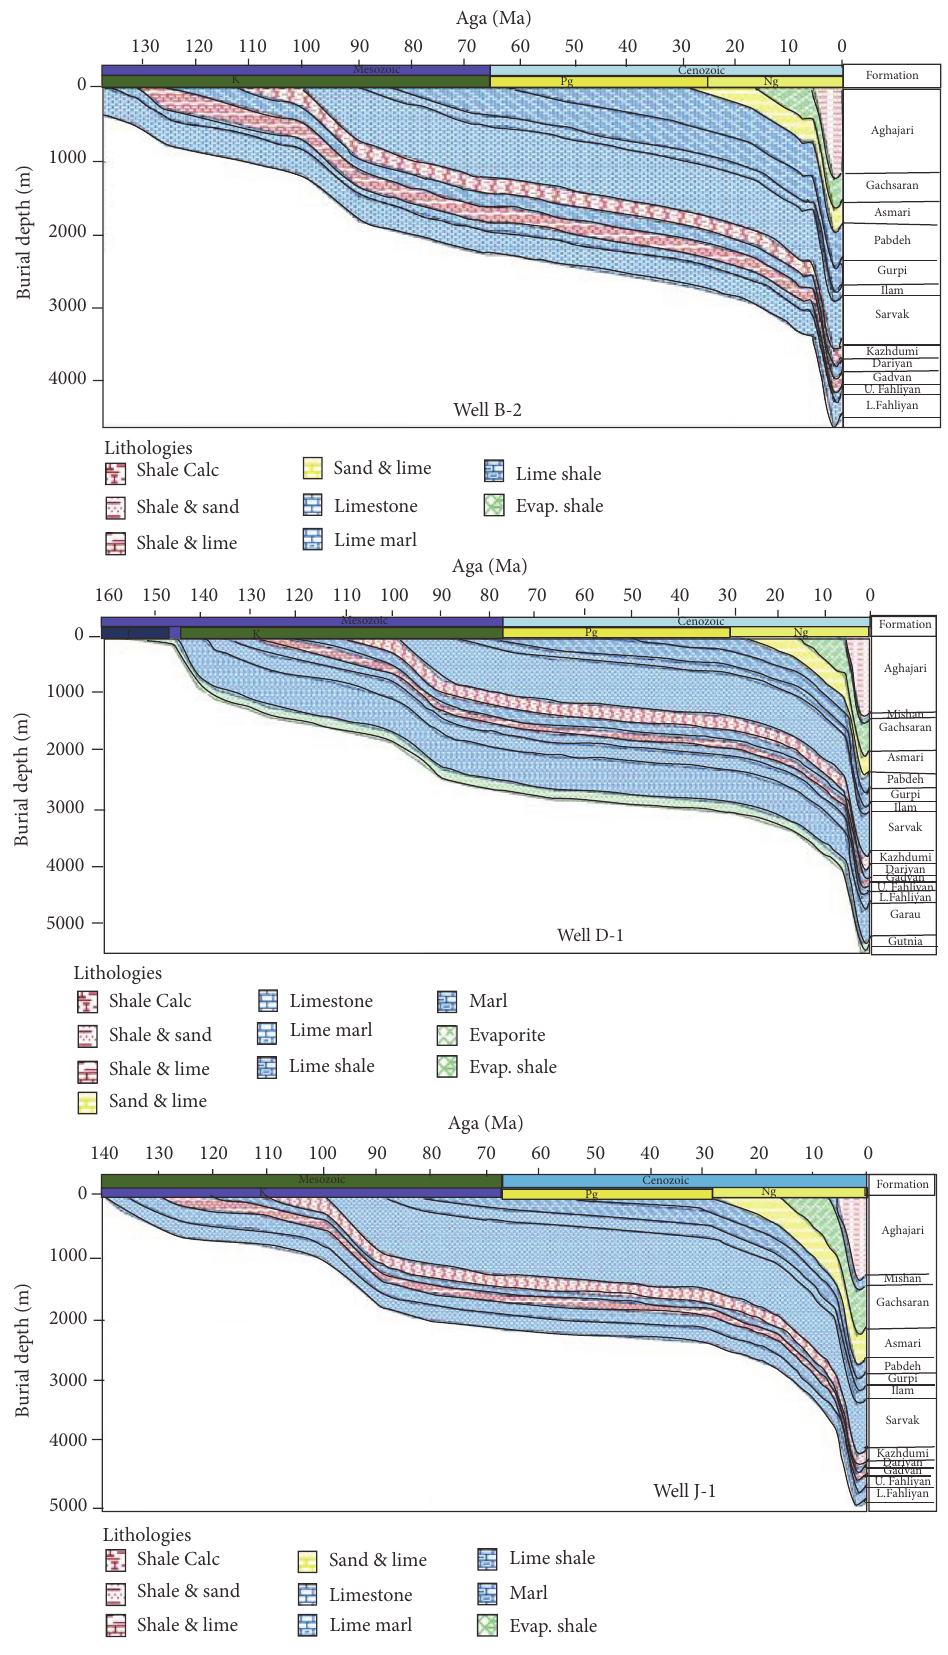
Figure 8: Burial history model for wells B-2, D-1, and J-1. There are two main breaks in depositional rate in all three wells, the first occurred from 99.6 My to 89.3 My (during Cenomanian-Turonian), and the more important second one occurred from 15.97 My to the present